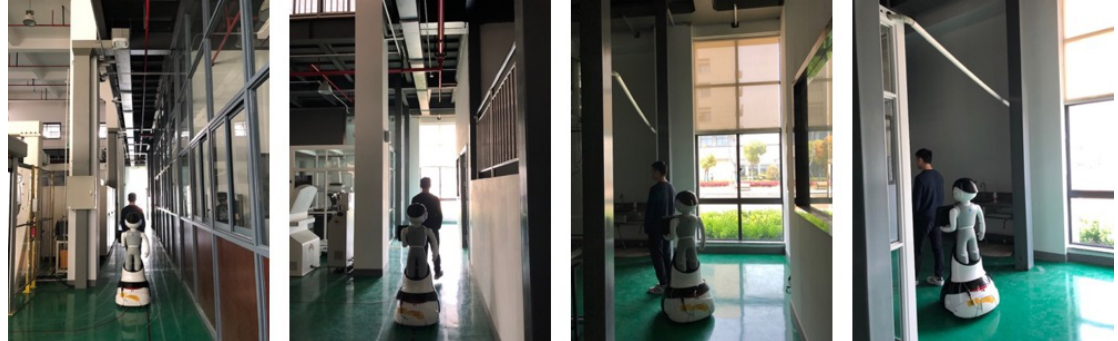
Figure 8. The target tracking robot following the experimenter with illumination